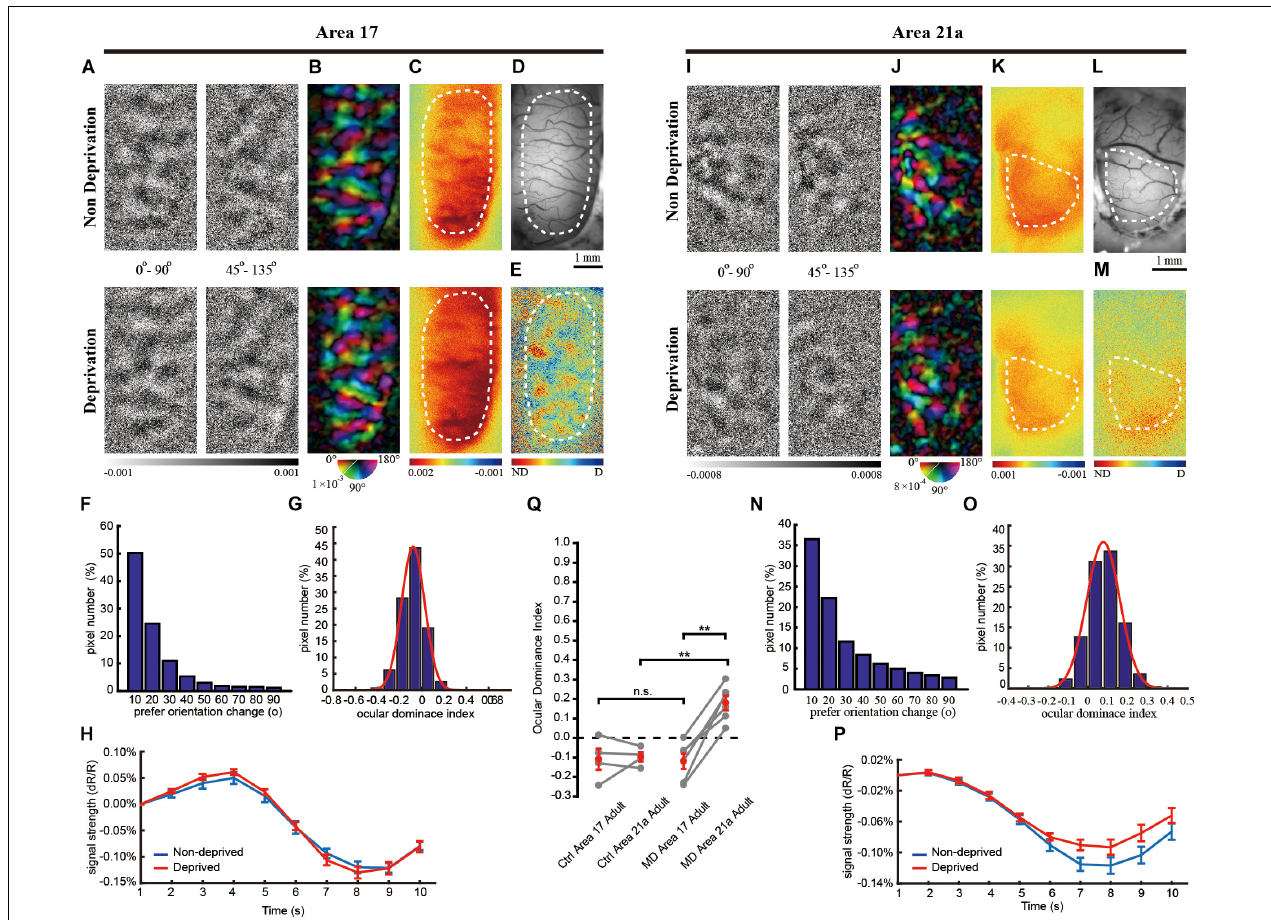
FIGURE 3 | The same-animal comparison between OD maps in areas 17 (A – H) and 21a (I – P) in adult cats monocularly deprived for 7 days ( A – P are from one typical cat, and Q illustrates data pairs of area 17 and area 21 from multiple animals). (A,I) Each row shows orientation differential maps evoked by monocular stimuli. Top: non-deprived eye. Bottom: deprived eye. Each column shows orientation differential maps with varying-orientation stimuli. Left: 0–90 ◦ . Right: 45–135 ◦ . (B,J) Orientation tuning is visualized by orientation polar maps, in which different colors represent the preferred stimulus orientation, and the gray scale represents the tuning strength of each pixel. Top: non-deprived eye. Bottom: deprived eye. (C,K) Global signal maps showing the averaged cortical response to stimuli with all orientations. Top: non-deprived eye. Bottom: deprived eye. (D,L) Blood vessel map. Scale bars: 1 mm. (E,M) OD maps of area 17 and area 21a. Red regions of the OD map represent domains dominated by non-deprived eyes, and blue regions represent domains dominated by deprived eyes. (F,N) The distribution of pixelwise differences of preferred orientation between the two eyes. (G,O) The distribution of the ODI of pixels in the dashed regions in (E,M) , respectively. (H,P) The time course of the global signals in area 17 and area 21a for the two eyes. Each global signal represents the mean of all the pixels in the ROI (shown as dotted region in C or K ). (Q) Statistical analysis of the OD shift in the adult cat. The mean ODI of all the pixels in the ROI was calculated as the ODI of this cortical area and shown as one individual point. N = 4 animals for the control group and n = 6 animals for the MD group. Area 17 and area 21a were imaged from the same animal, and the data points from the same animal are connected with lines. Data are means ± SEM; paired-sample and two-sample t -tests: ∗ p < 0.05, ∗∗ p <